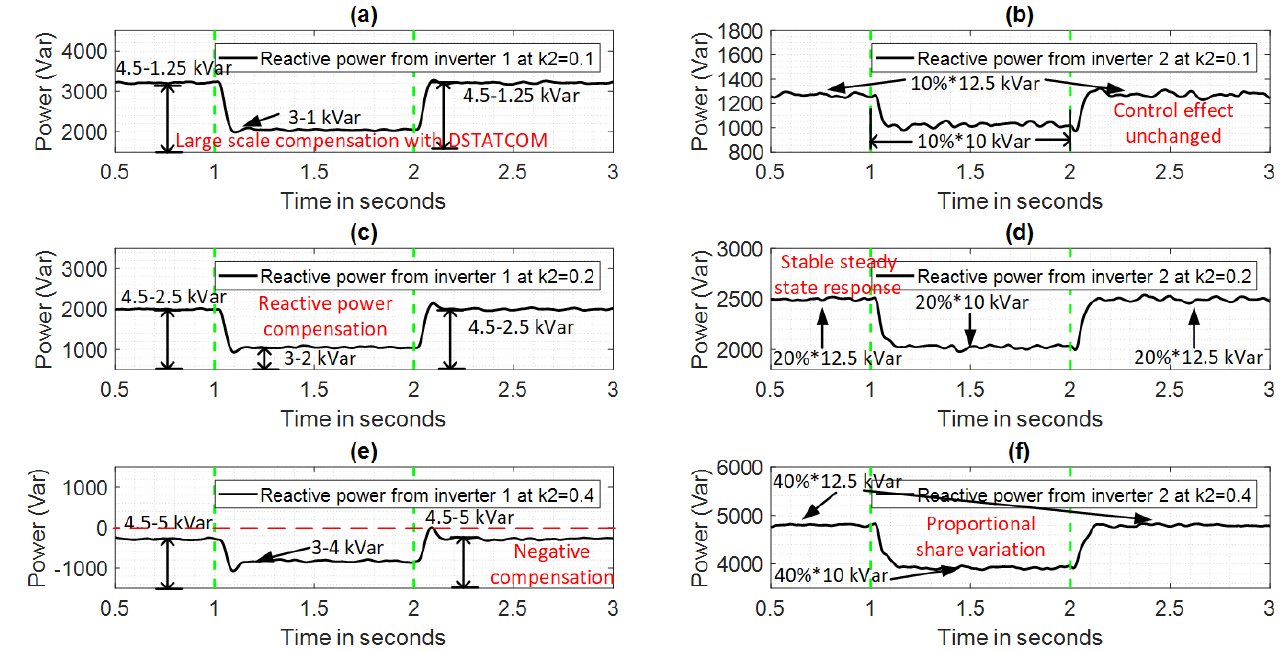
Figure 15. (cid:1863) (cid:2870) varying result. ( a ) Measured reactive power in inverter 1 when (cid:1863) (cid:2870) = 0.1 , ( b ) measured reactive power in Figure 15. k 2 varying result. ( a ) Measured reactive power in inverter 1 when k 2 = 0.1, ( b ) measured reactive power in inverter 2 when (cid:1863) (cid:2870) = 0.1 , ( c ) measured reactive power in inverter 1 when (cid:1863) (cid:2870) = 0.2 , ( d ) measured reactive power in in- inverter 2 when k 2 = 0.1, ( c ) measured reactive power in inverter 1 when k 2 = 0.2, ( d ) measured reactive power in verter 2 when (cid:1863) (cid:2870) = 0.2 , ( e ) measured reactive power in inverter 1 when (cid:1863) (cid:2870) = 0.4 , ( f ) measured reactive power in inverter inverter 2 when k 2 = 0.2, ( e ) measured reactive power in inverter 1 when k 2 = 0.4, ( f ) measured reactive power in inverter 2 when (cid:1863) (cid:2870) = 0.4. 2 when k 2 =